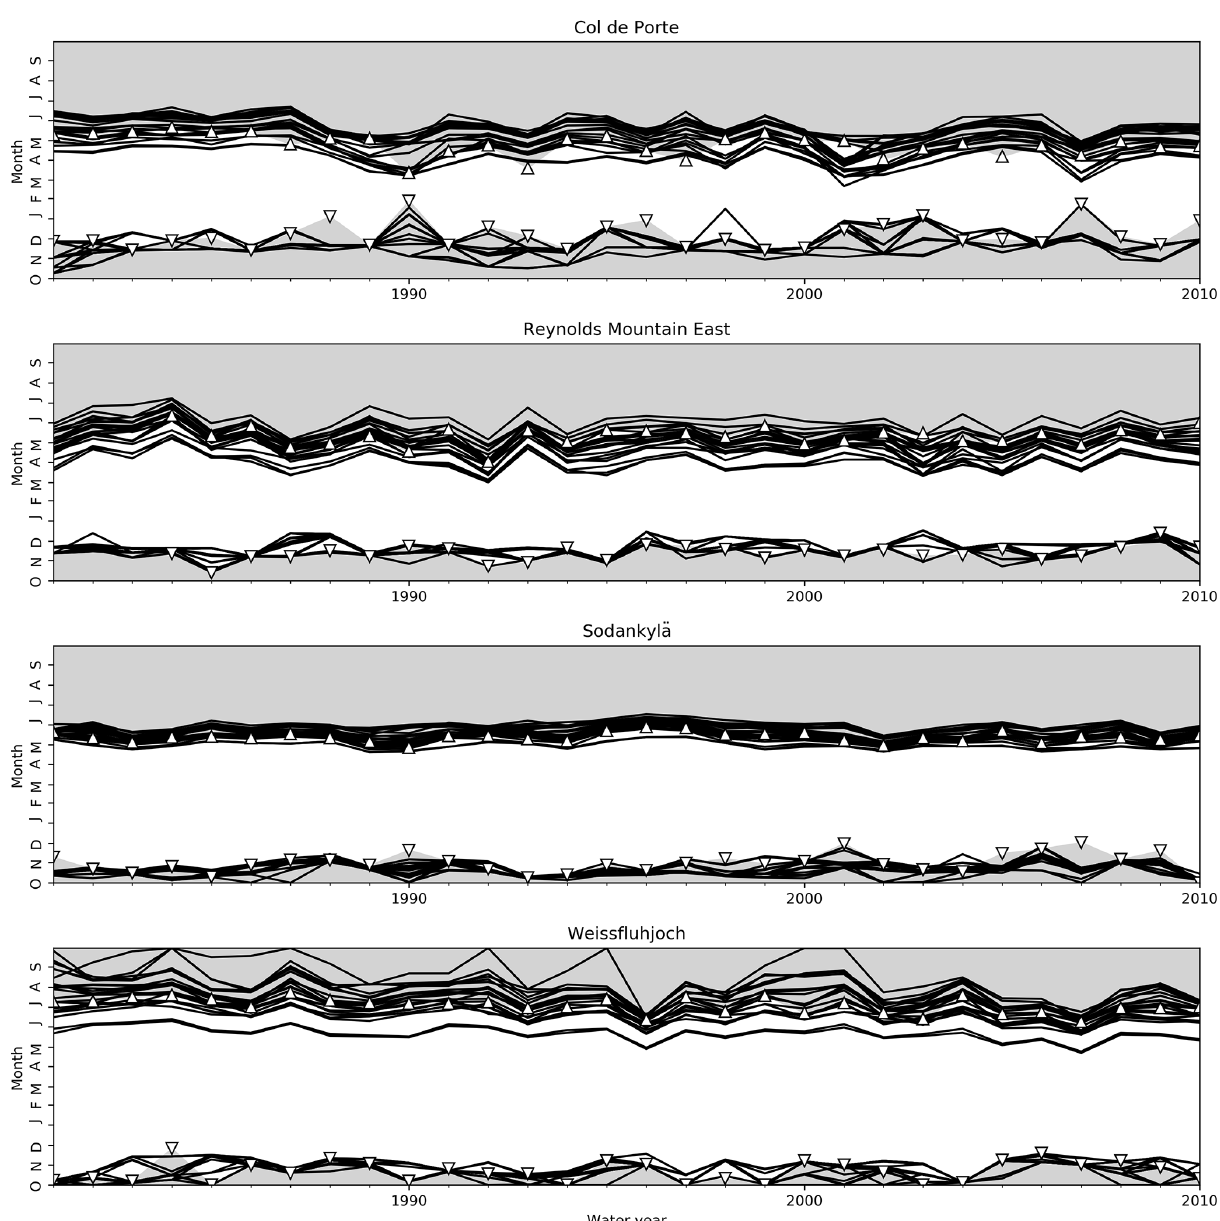
Figure A1. ESM-SnowMIP model predictions (lines) compared with observed start ( ∇ ) and end ( (cid:52) ) dates of continuous seasonal snow cover at the sites. Snow-free periods are shaded (ephemeral summer snow cover is not